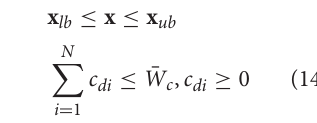
Frontiers in Built Environment |